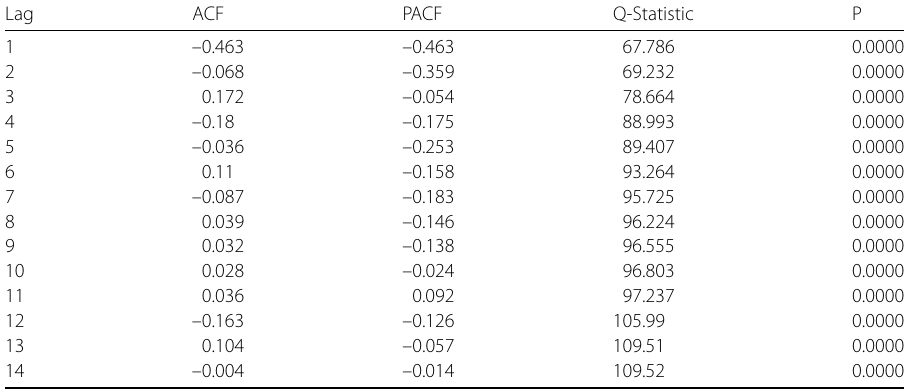
Table 3 The autocorrelation function value and the partial autocorrelation function value of the sequence